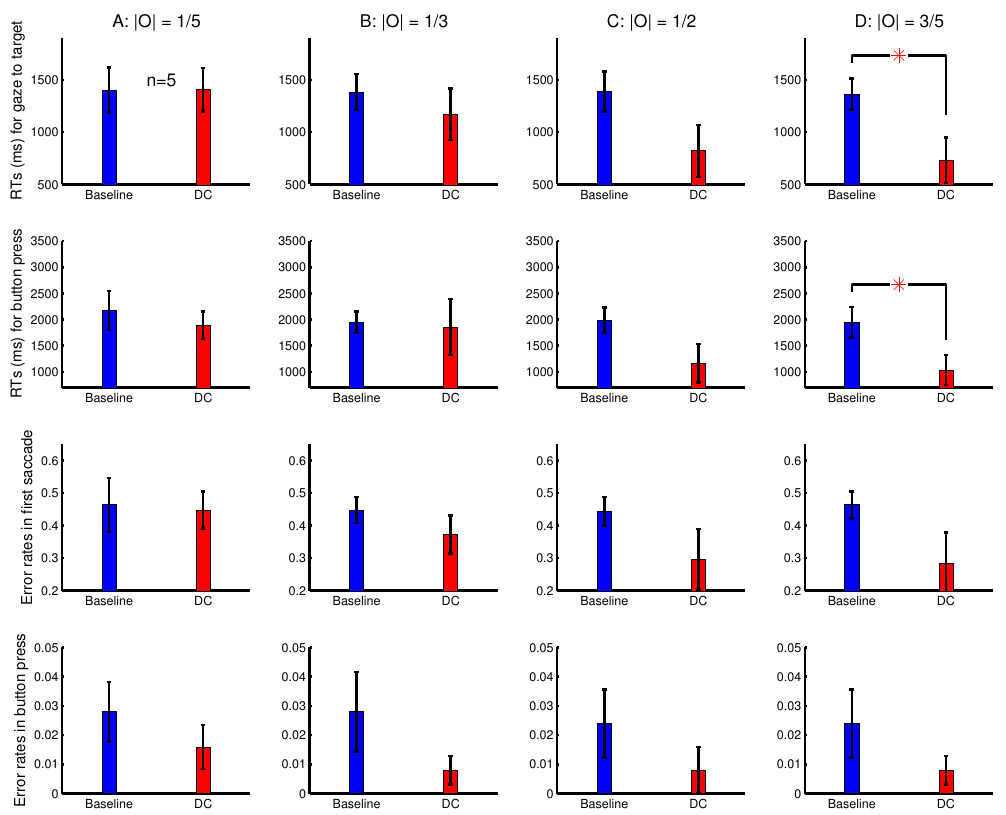
Figure 6. Another experiment (Experiment 3) showing increased saliency of the ocularity singleton by its increased ocularity contrast. Shown are the average behaviour from n = 5 subjects in the task to search for a letter ‘T’ among letter ‘L’s in 17 rows by 17 columns of letters. The ocularity magnitude O was weak ( A ), medium-low ( B ), medium-high ( C ), or strong ( D ) in each trial and was the same | | s R of the ocularity singleton (in a DC trial) across all the letters in a single trial. The ocularity O = s L − was the negative of the ocularity for all the other letters in the trial. Each subject’s data were from an experimental session in which the trials from the eight conditions (baseline and DC for each of (A–D)) were randomly